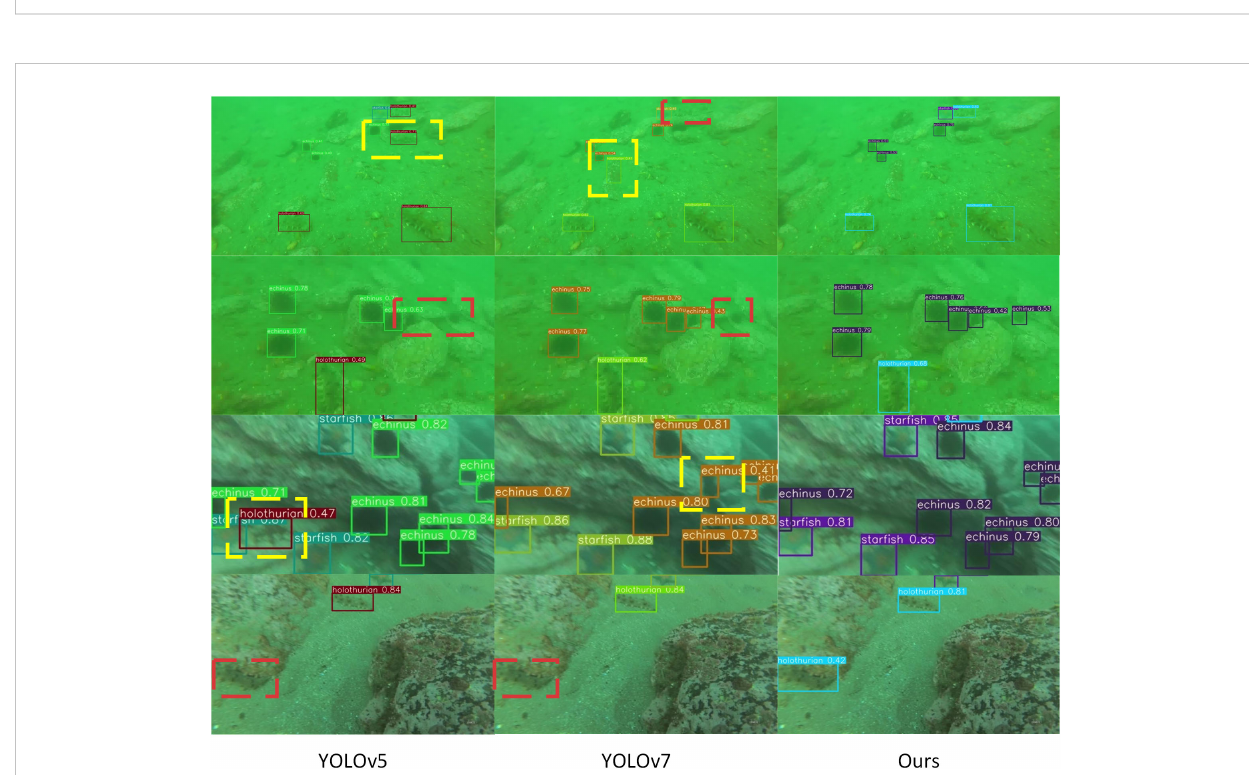
FIGURE 10 More detailed visualization comparison of detection results with YOLOv5, YOLOv7, and